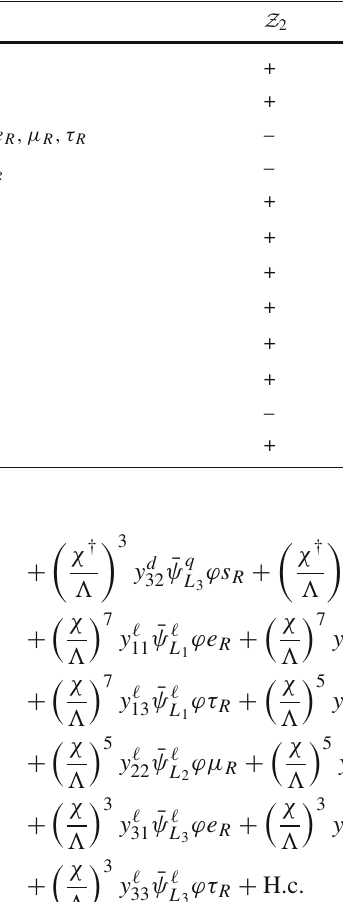
Table5 Thechargesofleftandright-handedfermionsofthreefamilies of the SM, right-handed neutrinos, Higgs, and singlet scalar field under Z Z 2 and 9 symmetries, where